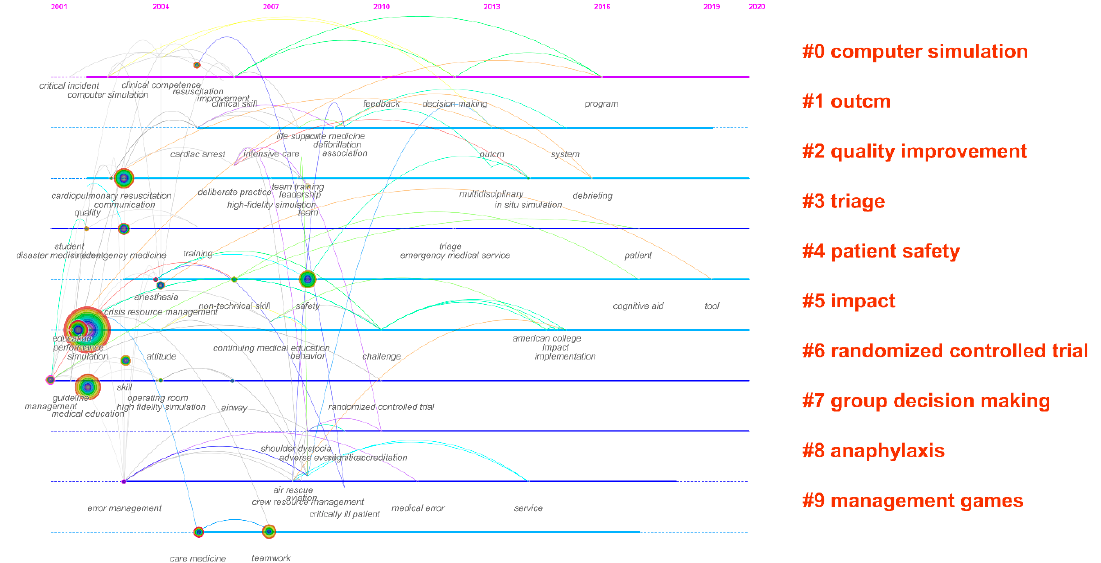
Figure 8. Timeline view of research thematic horizons and keyword changes between 2021 and 2020.